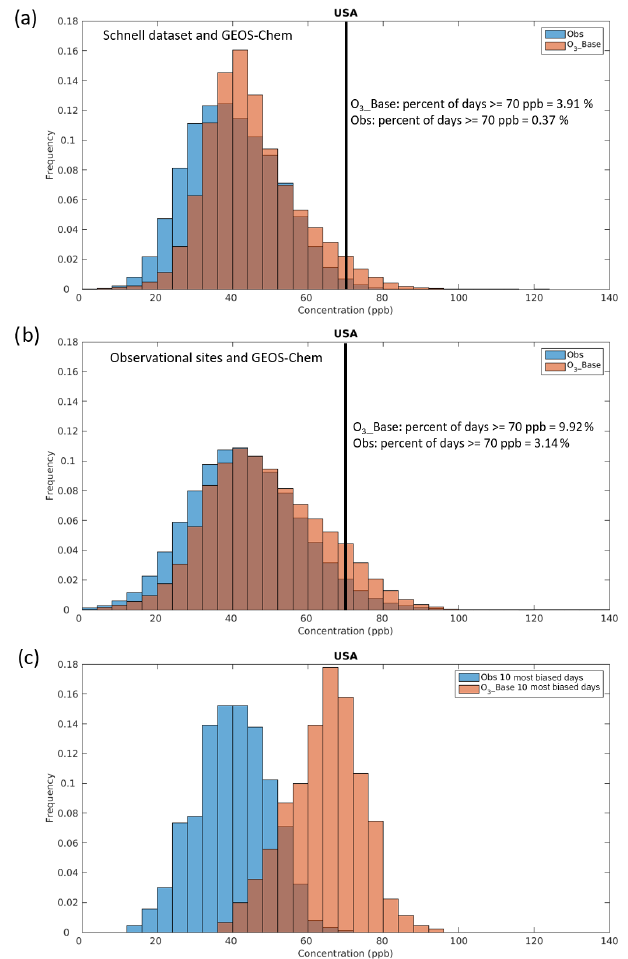
Figure 1. Frequency distribution of regionally averaged US MDA8 O 3 values from 2004 to 2012 in the (a) Schnell and Prather (2017) dataset interpolated to 2 ◦ × 2 . 5 ◦ and (b) at individual observational sites prior to averaging over each of the 10 EPA regions (total num- ber of points is 9 years × 365 or 366 days × 10 regions) in the observations (blue) and the GEOS-Chem model (orange). (c) As in panel (b) but for the 10 most biased days in each region (total num- ber of points is 9 years × 10 days × 10 regions). The line drawn at 70ppb in panels (a, b) is the current O 3 NAAQS